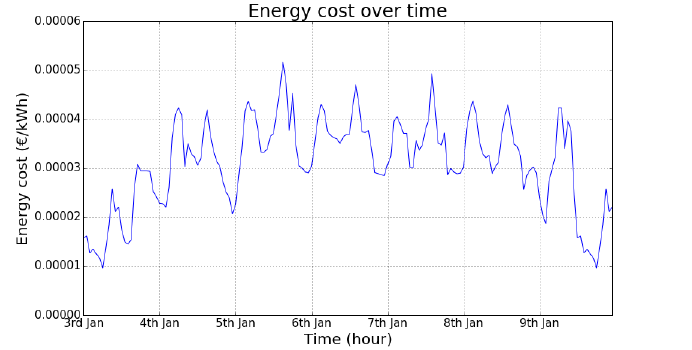
Figure 2. Weekly behavior of the energy cost per